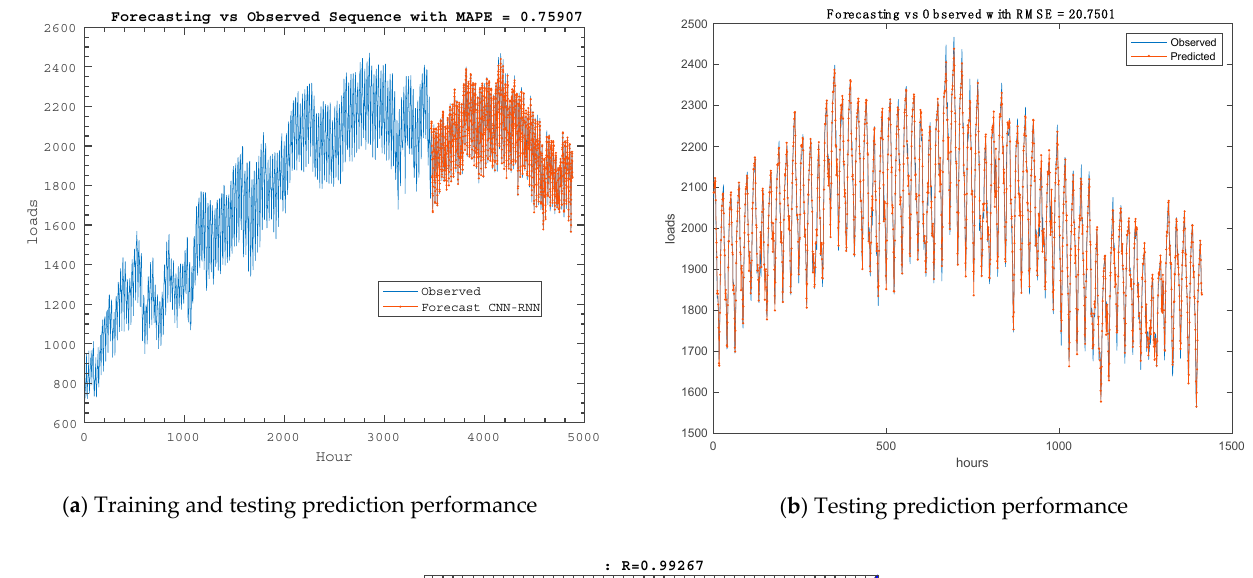
Figure 13. ANN model prediction performance for the Jeddah load: ( a ) training and testing, ( b ) testing, and ( c ) error histogram plot.